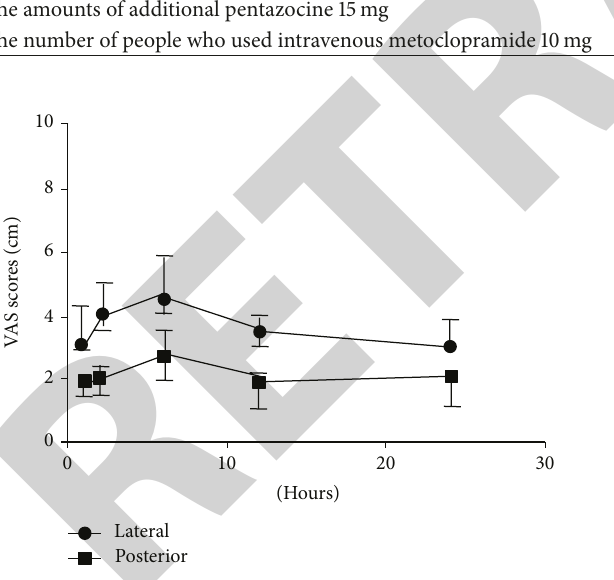
Figure 2: Postoperative VAS scores twelve and twenty-four postop- erativehoursduringmovement:dataexpressedasamedian(twenty- fifth to seventy-fifth